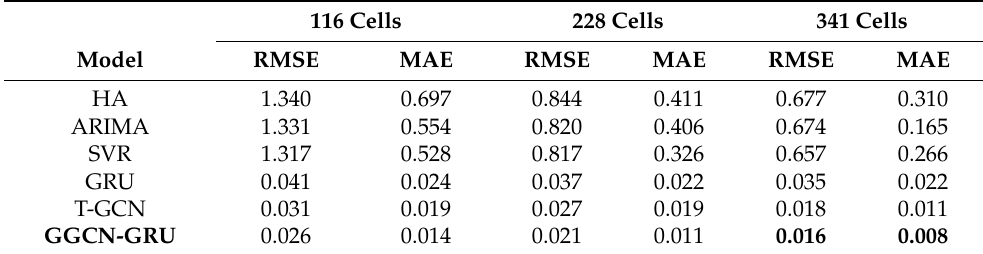
Table 4. Comparison of the GGCN-GRU method and other spatio-temporal prediction methods. 116 Cells 228